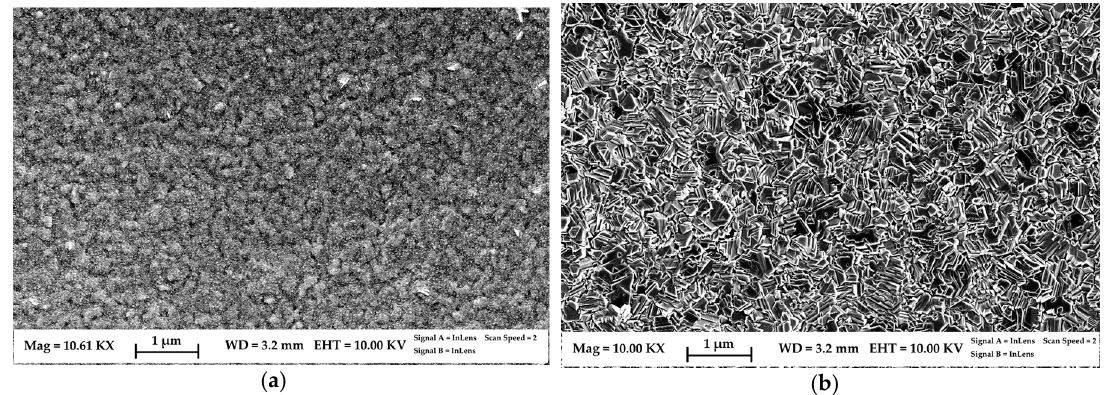
Figure 9. SEM images showing the morphology of the: ( a ) precursor made by depositing in sequence InSe–GaSe–Cu–GaSe on ceramic substrate; and ( b ) same sample after selenization. The highest performing solar cells obtained with this method yielded the following parameters: All cell parameters refer to an area of around 1 cm 2 (if not expressly stated otherwise). V OC = 610 mV, J SC = 36.79 mA/cm 2 , FF = 0.61, and η = 13.69%. Measurements were acquired at